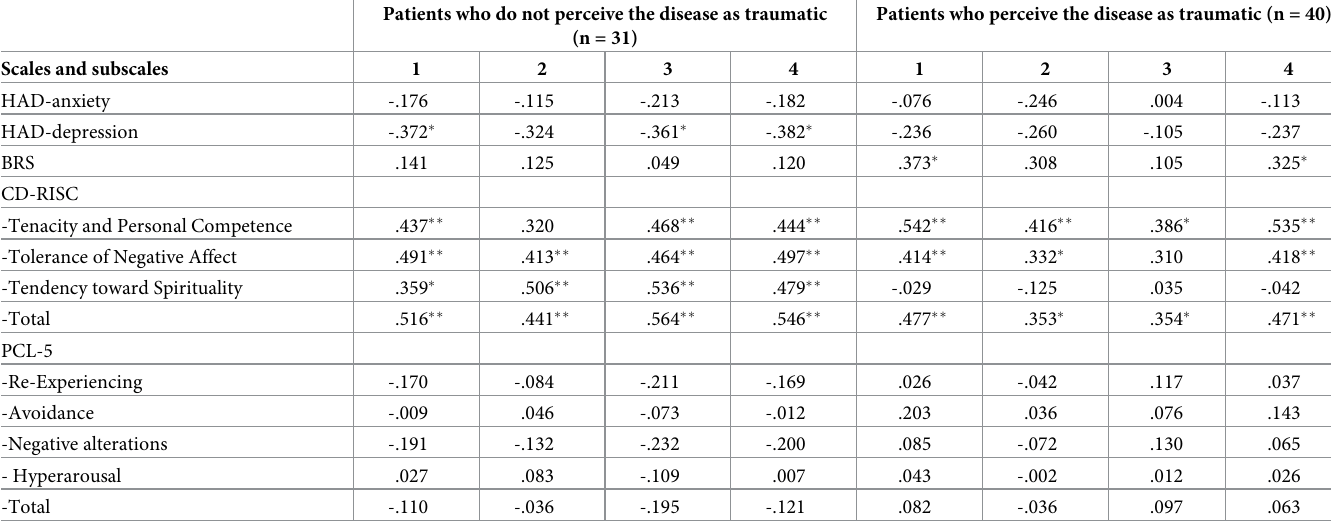
Table 3. The relationship between PTGI scores and other scale scores (for two